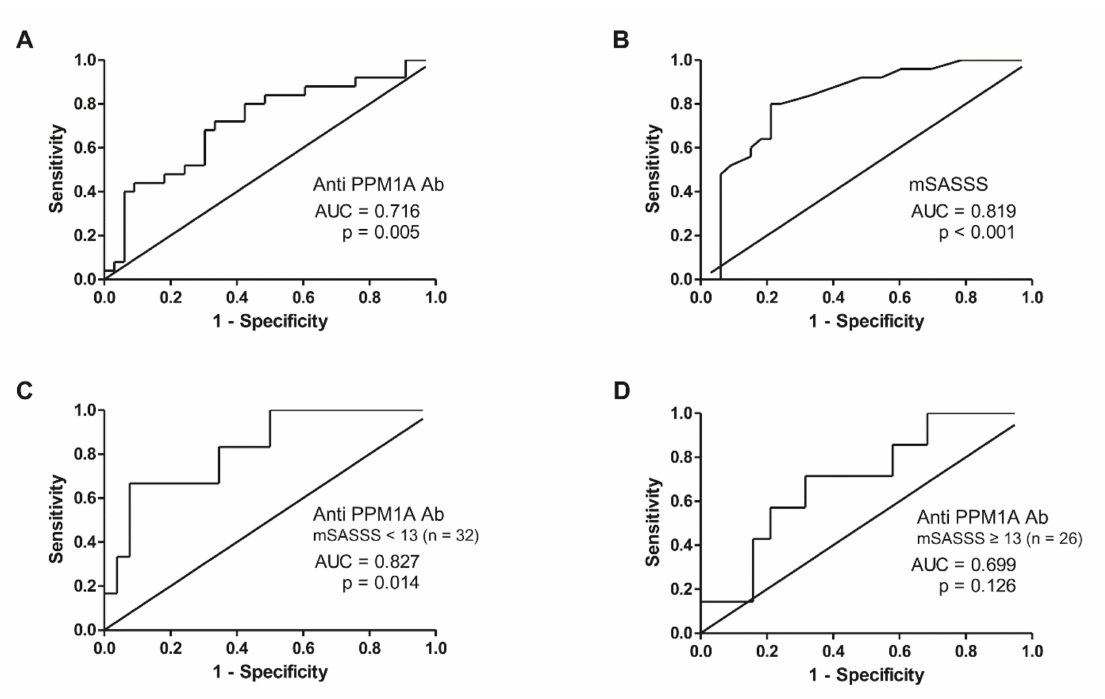
Figure 2. ROC analysis predicting radiographic progression in AS patients treated with anti-TNF agents with regards to ( A ) anti-PPM1A antibodies, ( B ) mSASSS, ( C ) anti-PPM1A antibodies in patients with mSASSS < 13 units, and ( D ) anti-PPM1A antibodies in patients with mSASSS ≥ 13 units. ROC: Receiver operating characteristic, TNF: Tumor necrosis factor, PPM1A: Protein phosphatase magnesium-dependent 1A, AUC: Area under the curve, mSASSS: Modified Stoke Ankylosing Spondylitis Spinal